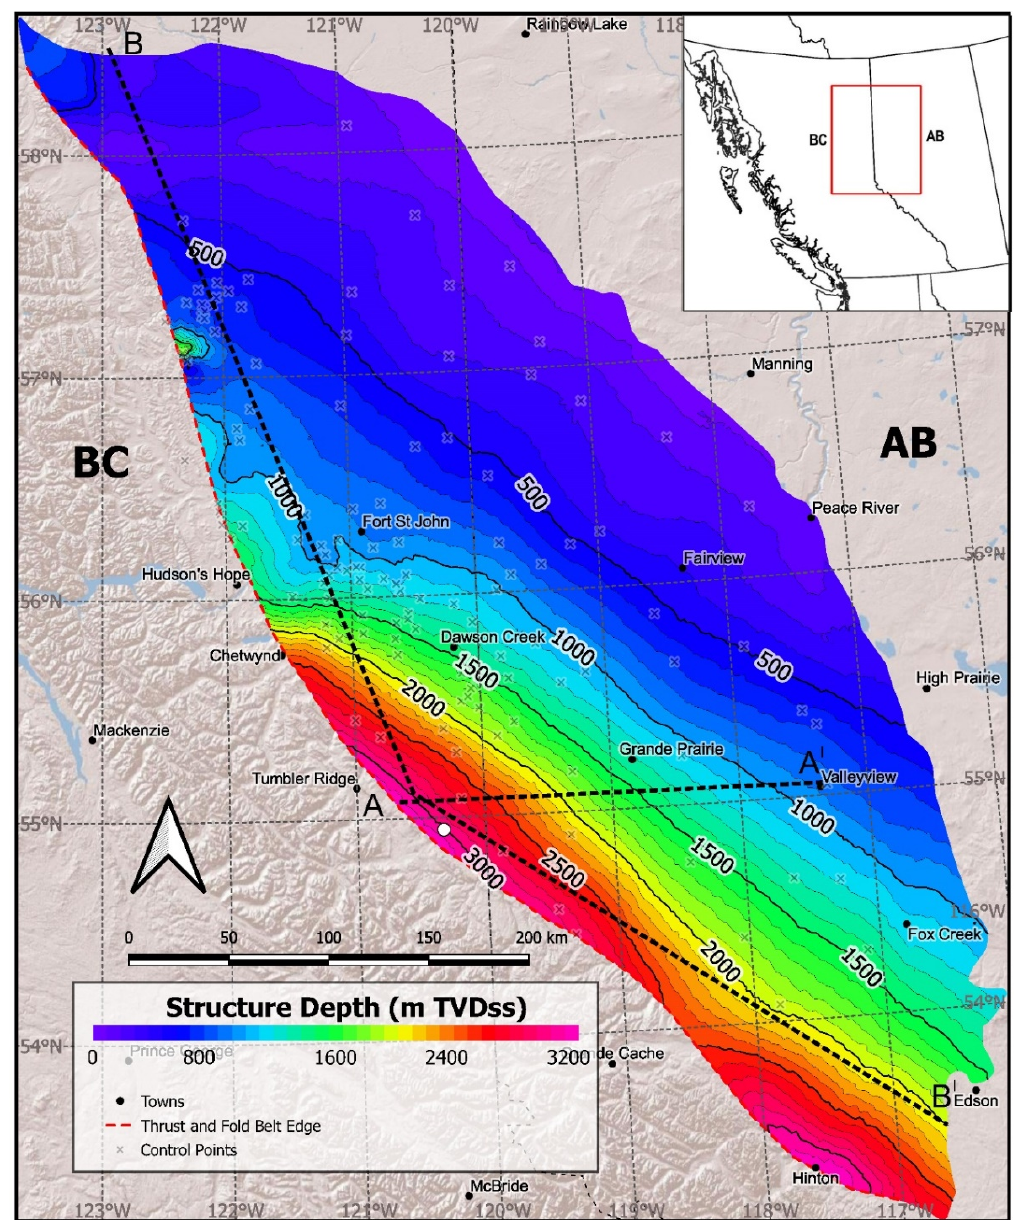
Figure 2. Structure on top of the Montney Formation in British Columbia and Alberta. The structure map shows an increasing depth to the top of the Montney Formation towards the southwest. The white dot shows the location of the one-dimensional basin model.